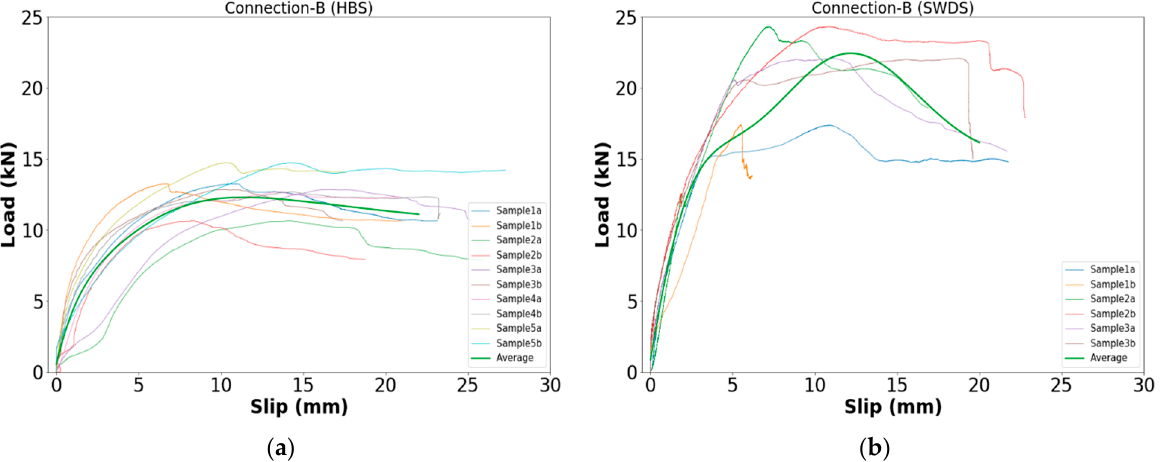
Figure 20. The load-slip curve of Connection-B: ( a ) HBS screw; ( b ) SDWS screw.